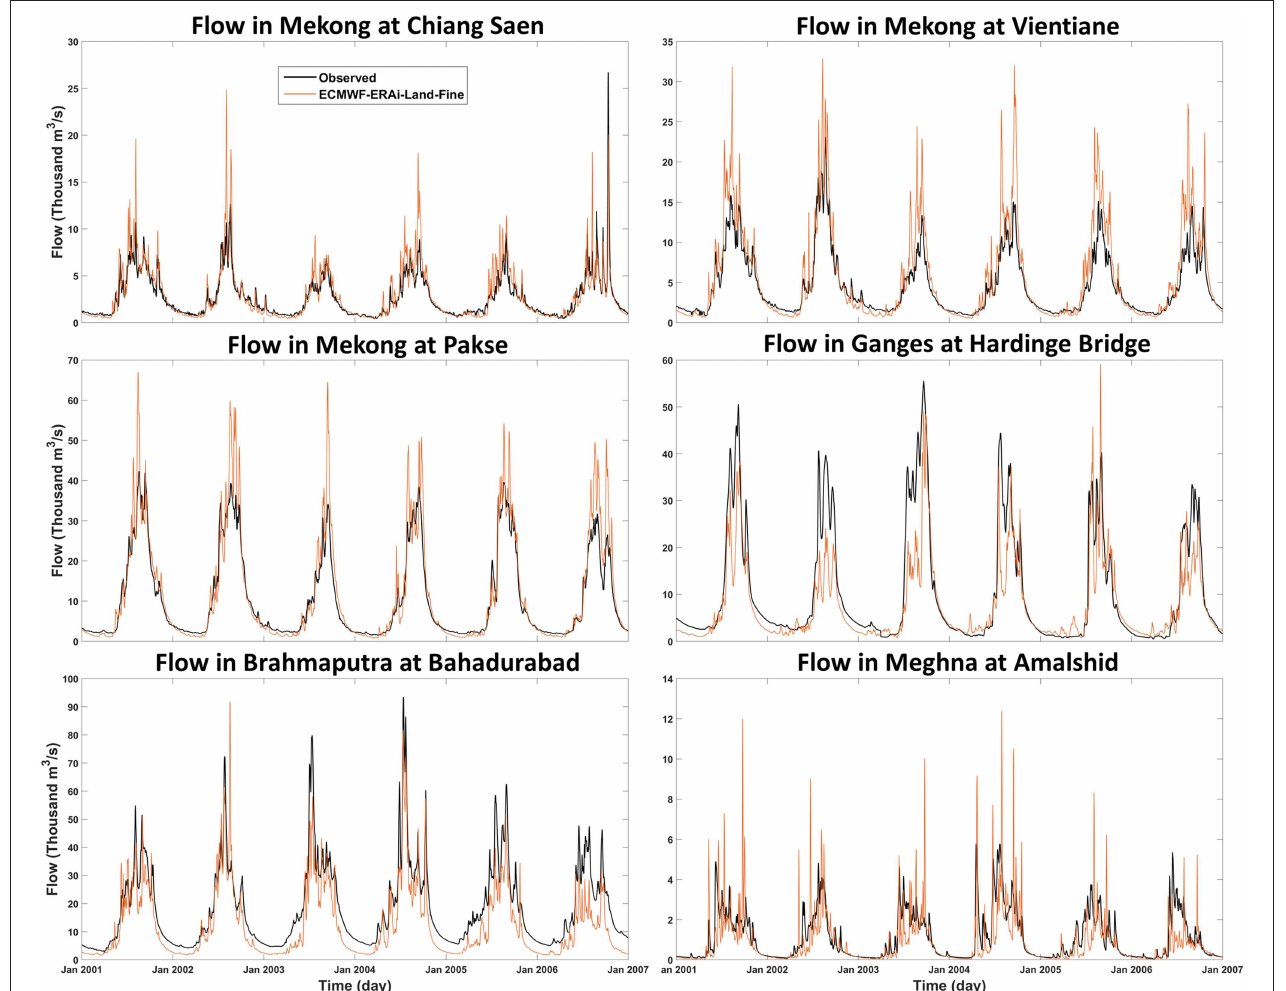
FIGURE 10 | Comparison of the simulated daily stream flow using the ECMWF-ERA-interim/Land outputs in the fine scale routing model (i.e., with fine river network) and in-situ discharge at different locations of the Mekong and GBM basins.